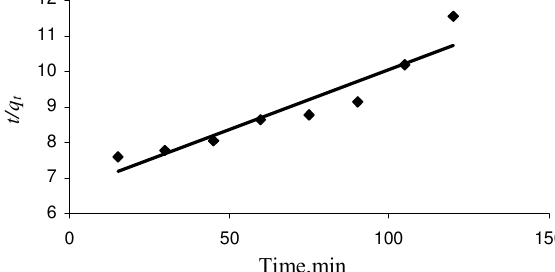
Figure 9. Pseudo-second order model for the collected